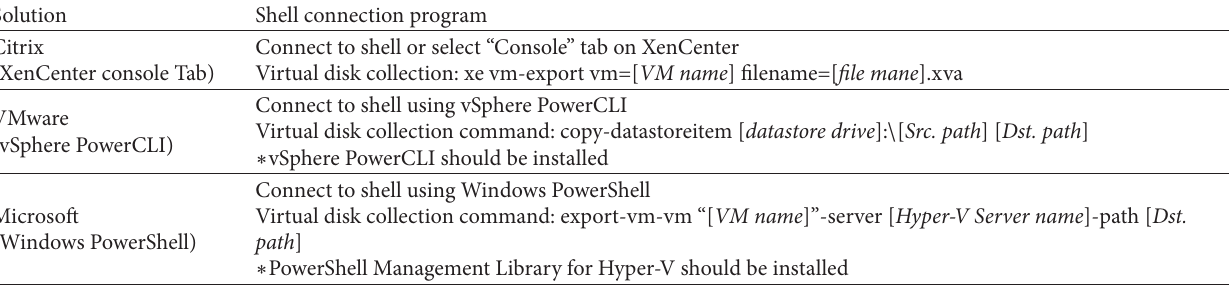
Table 9: Acquisition of virtual machine data using a hypervisor CLI with default utilities for each solution.